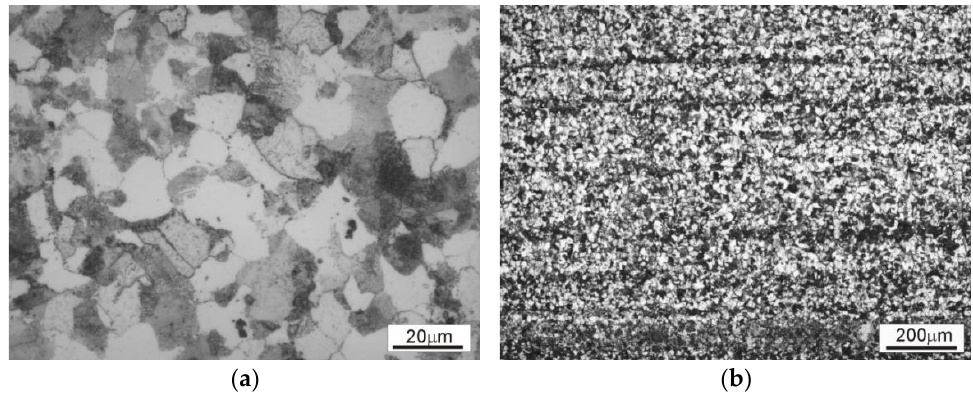
Figure 1. The microstructures of the 4130 steel in as-delivered condition: ( a ) transverse cross-section, ( b ) longitudinal cross-section.